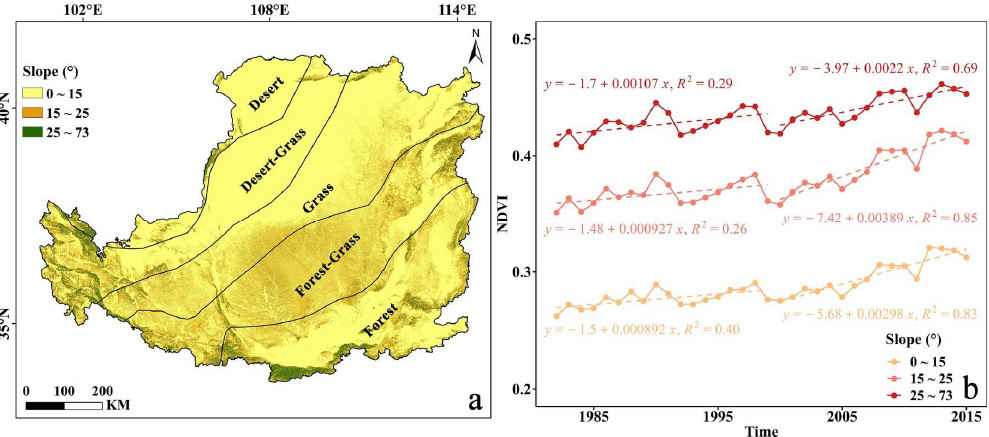
Figure 11. ( a ) Slope map of the LP, and ( b ) NDVI variation trends in different slopes.